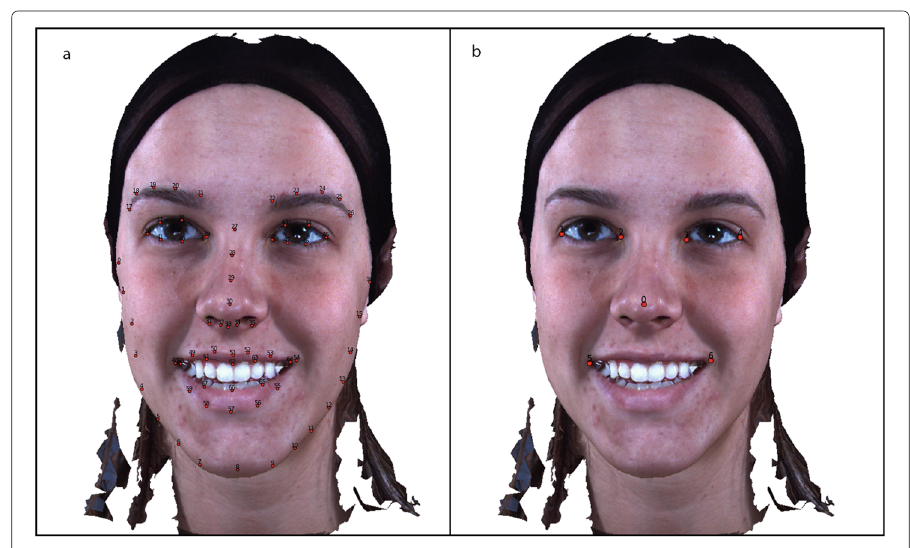
Fig. 1 Two different landmarks schemes. a iBUG-68 . b M7